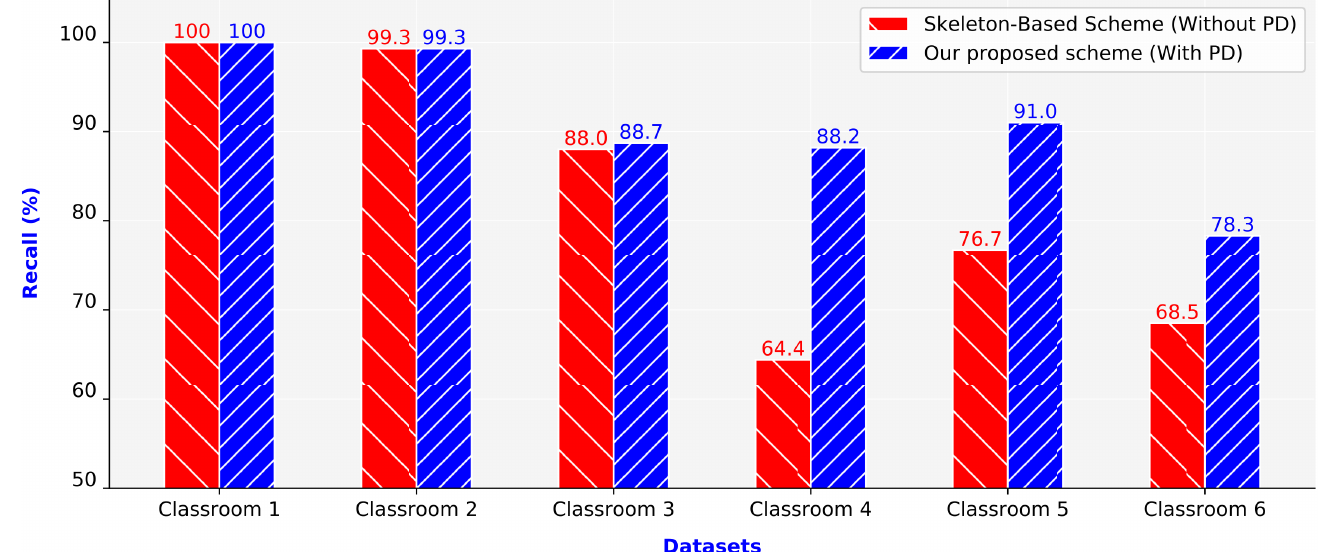
Figure 12. Recall values of the